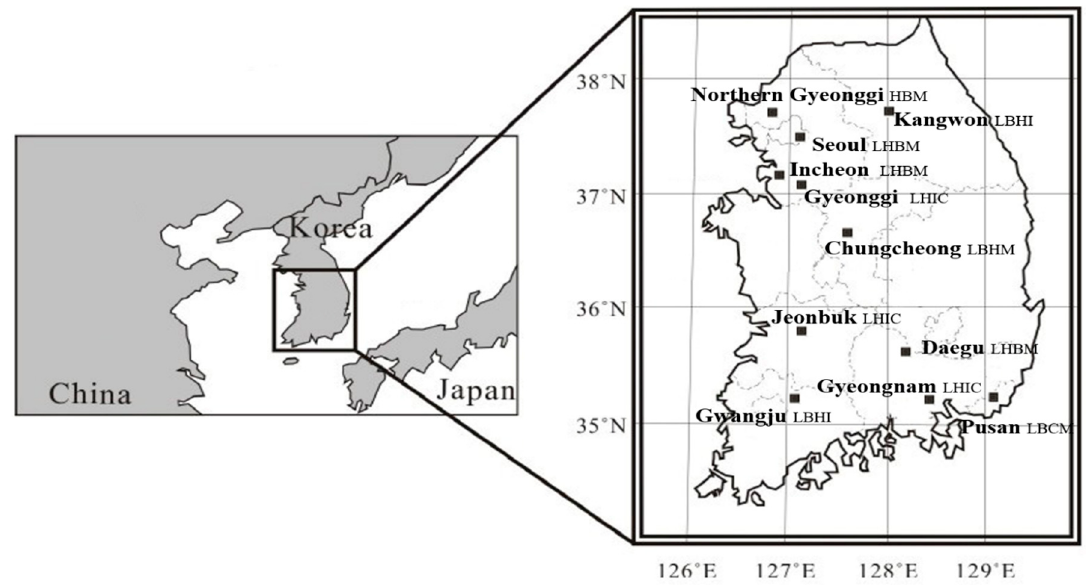
Figure 6. O ffi ce location of 11 regions. (L: Lighting energy; H: Heating energy; B: Baseload energy; Figure 6. Office location of 11 regions. ( L: Lighting energy; H: Heating energy; B: Baseload energy; C: Cooling C: Cooling energy; I: Intermediate energy; M: energy; I: Intermediate energy; M: Month-time.)